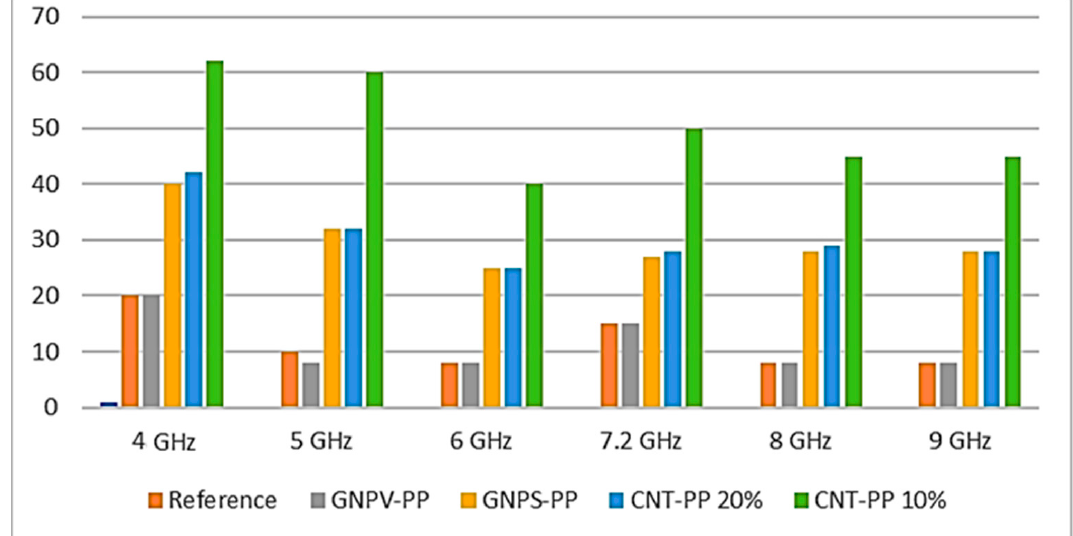
Figure 11. Graphical representation of the various materials’ attenuation efficiency.